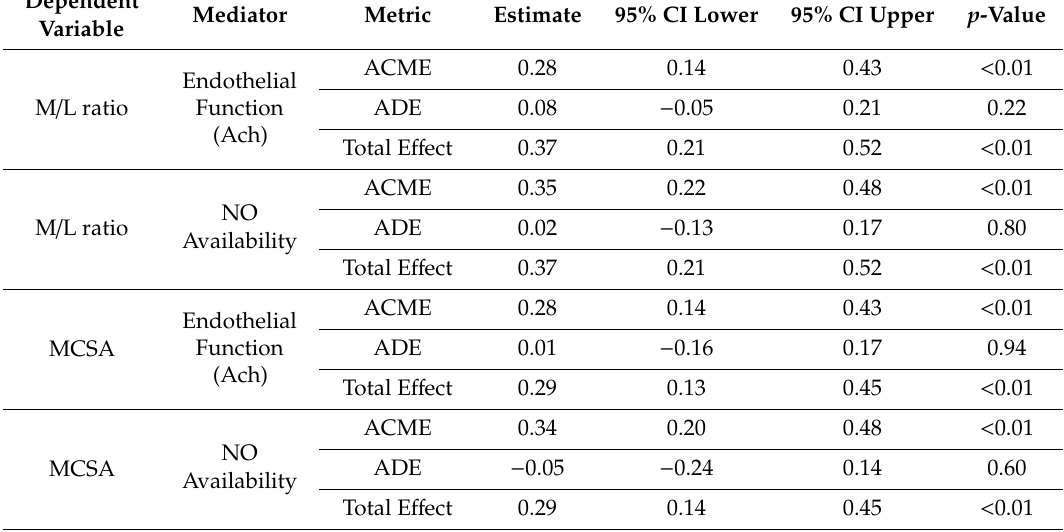
Table 3. Estimation of the average direct e ff ect (ADE) of serum uric acid levels and average